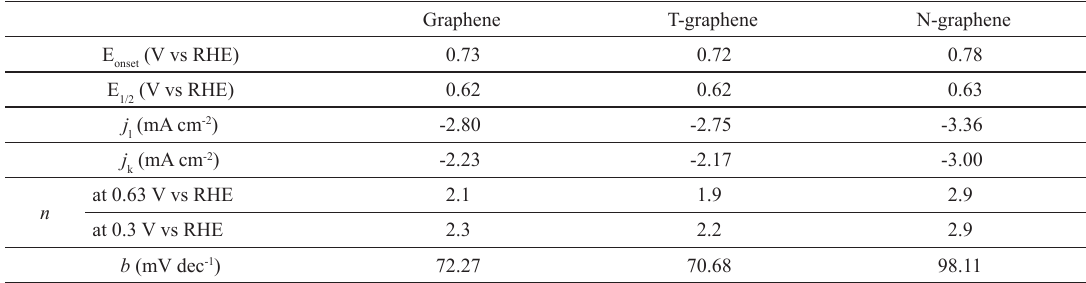
Table 3. ORR activity parameters extracted from Figures 4, 8 and 9 for the electrocatalysts.